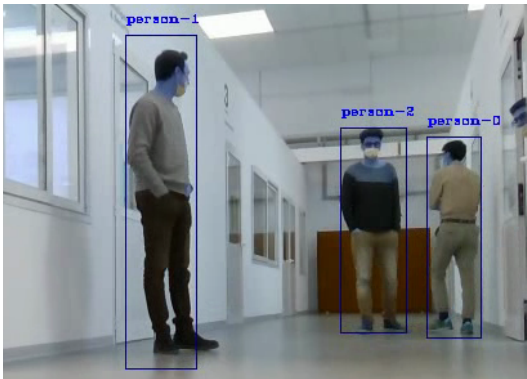
Figure 4. People detected by the YOLOv3 framework on the image acquired by the camera.